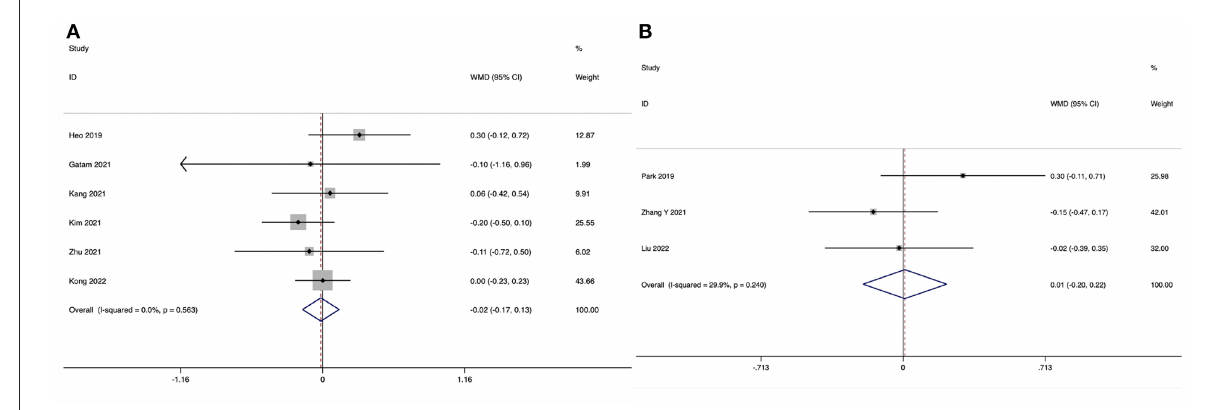
FIGURE8 Forest plot of the Visual Analog Scale score for leg pain at the final follow-up. (A) ULIF vs. MI-TLIF; (B) ULIF vs. PLIF.